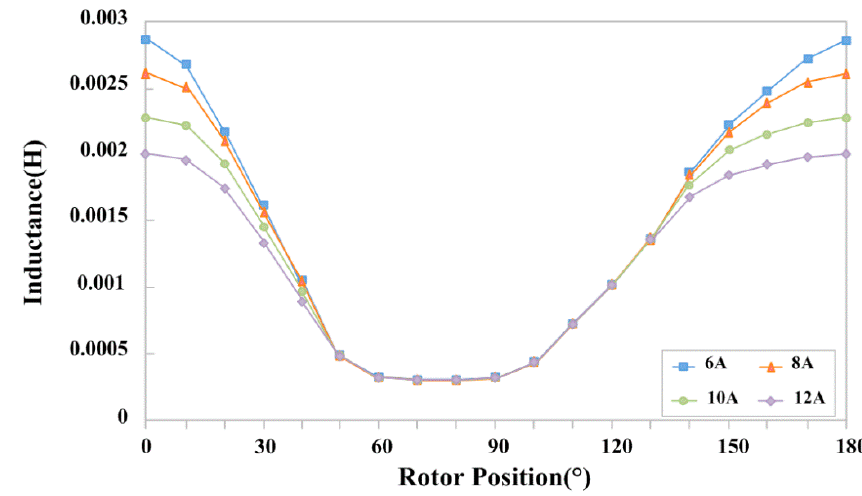
Figure 19. Simulated inductance profiles using FEM.